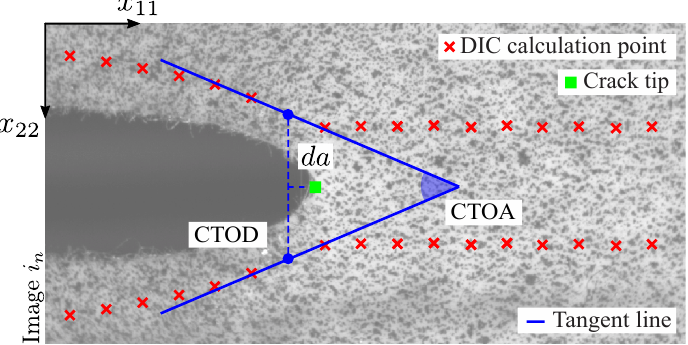
Figure 5. CTOD and CTOA